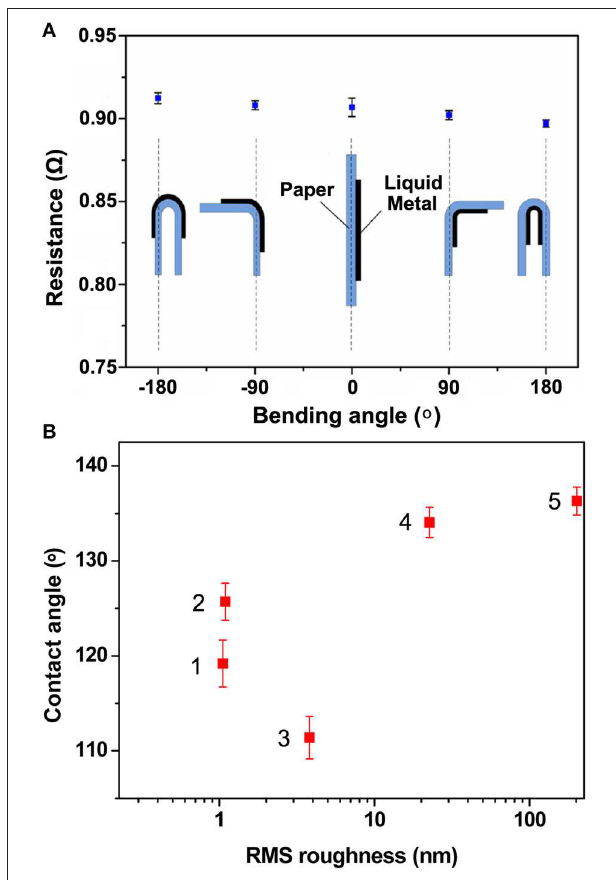
FIGURE 4 | Resistance values of a printing wire at five different bending angles. The length and the width of the wire are 18cm and 1mm, respectively (A) , and measured contact angles of liquid metal droplets on substrates with different RMS roughnesses. The numbers 1 to 5 represent silicone wafer, glass, PVC plastic film, PDMS and paper substrates, respectively (B) . Reproduced with permissions from Zheng et al. (2013). Copyright 2013, Springer Nature. Reproduced with permissions from Wang and Liu (2015b). Copyright 2015, Royal Society of Chemistry.